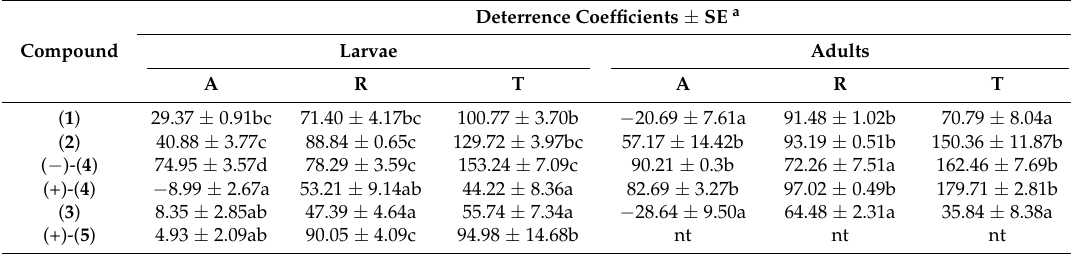
Table 2. Feeding deterrent activity of the studied compounds in choice and no-choice tests against A. diaperinus .